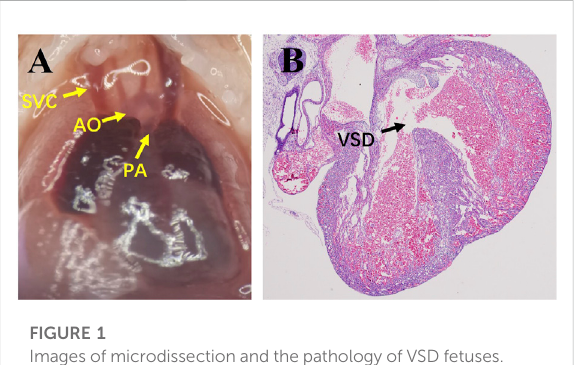
FIGURE 1 Images of microdissection and the pathology of VSD fetuses. (A) , Microdissection shows the correct connection of major vessels; (B) , pathology shows VSD. SVC, superior vena cava; AO, aorta; PA, pulmonary artery; VSD, ventricular septal